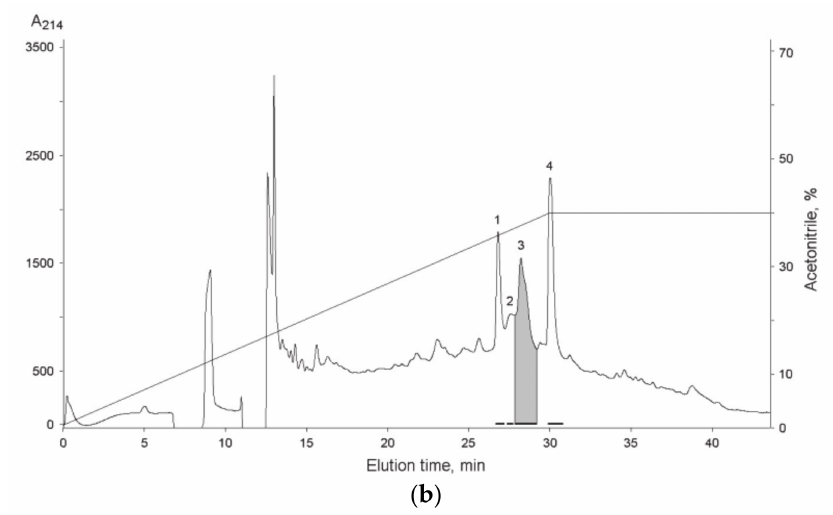
Figure 1. Isolation of S. coccinea bioactive compounds. ( a ) Hydrophobic chromatography of ethanol extract on polychrome-1 column (4.5 cm × 7 cm). 1—Hydrophilic fraction eluted with water; 2—hydrophobic fraction eluted with 40% aqueous ethanol. ( b ) RP-HPLC of fraction 2, obtained